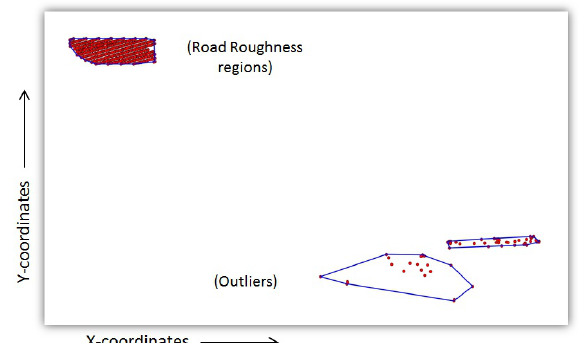
Figure 2: Multi-level Otsu threshold values determined for inten- sity surface.